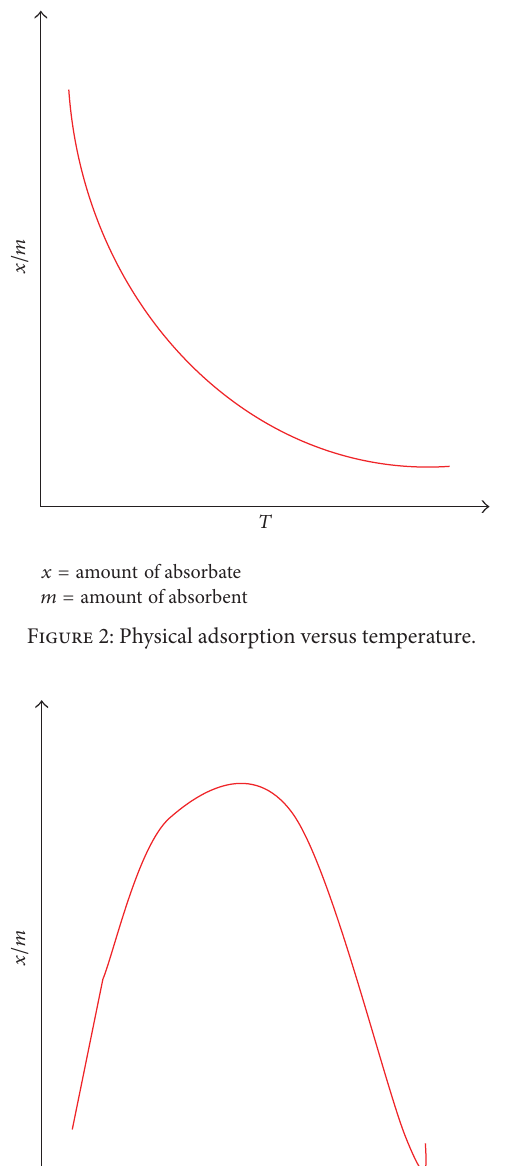
adsorbate on adsorbent takes place and it has a high enthalpy of adsorption (i.e., Δ𝐻 adsorption = 200 to 400 KJ/mol). This phenomenon first increases and then decreases with a rise in temperature